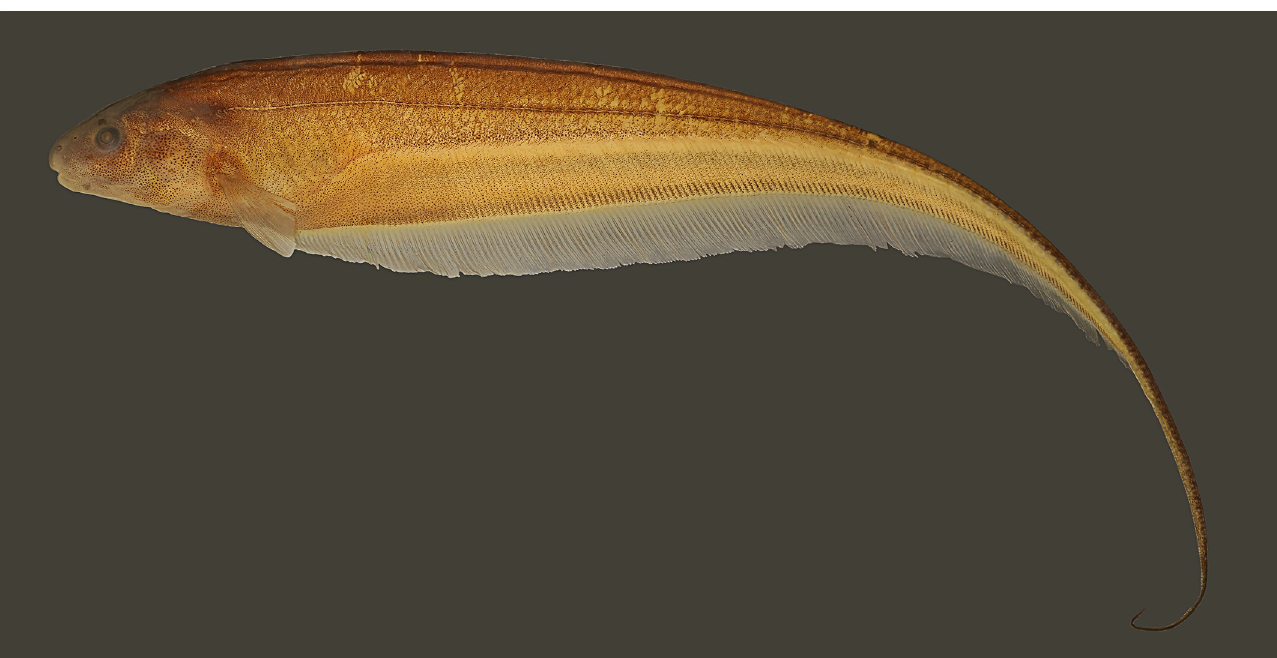
Fig 1. Lateral view of Eigenmannia sirius , MZSUP 121668, holotype, 127.5 mm L EA , Mato Grosso, Brazil, rio Mutum, tributary of rio Juruena, rio Tapajo´s basin.